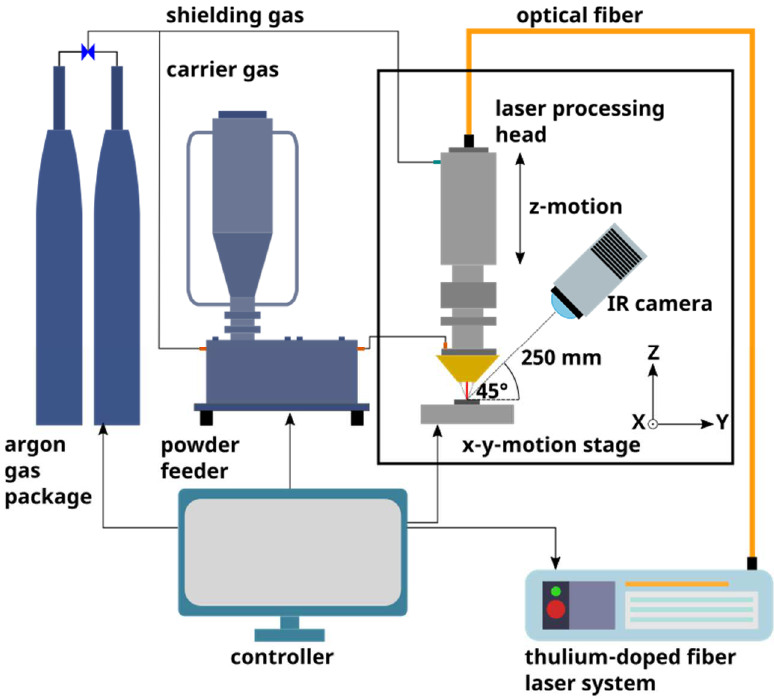
Figure 1. Schematic of the DED-LB/P setup for generating polymer coatings on stainless steel substrates.